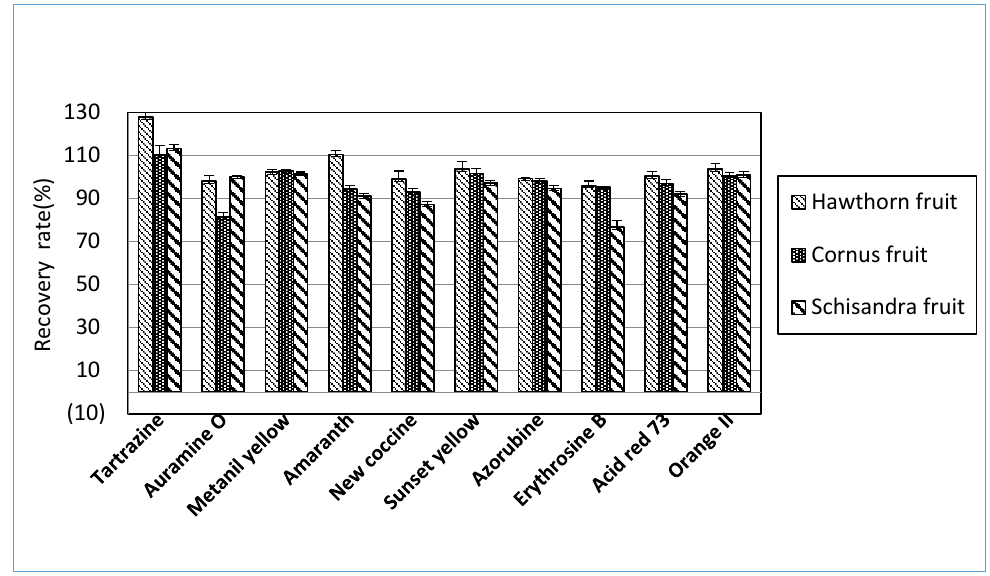
Figure 2. Mean recoveries of each synthetic dye obtained from each herbal medicine spiked in low, medium, or high concentrations of the mixed ten standard solutions using the proposed HPLC-PDA analysis.